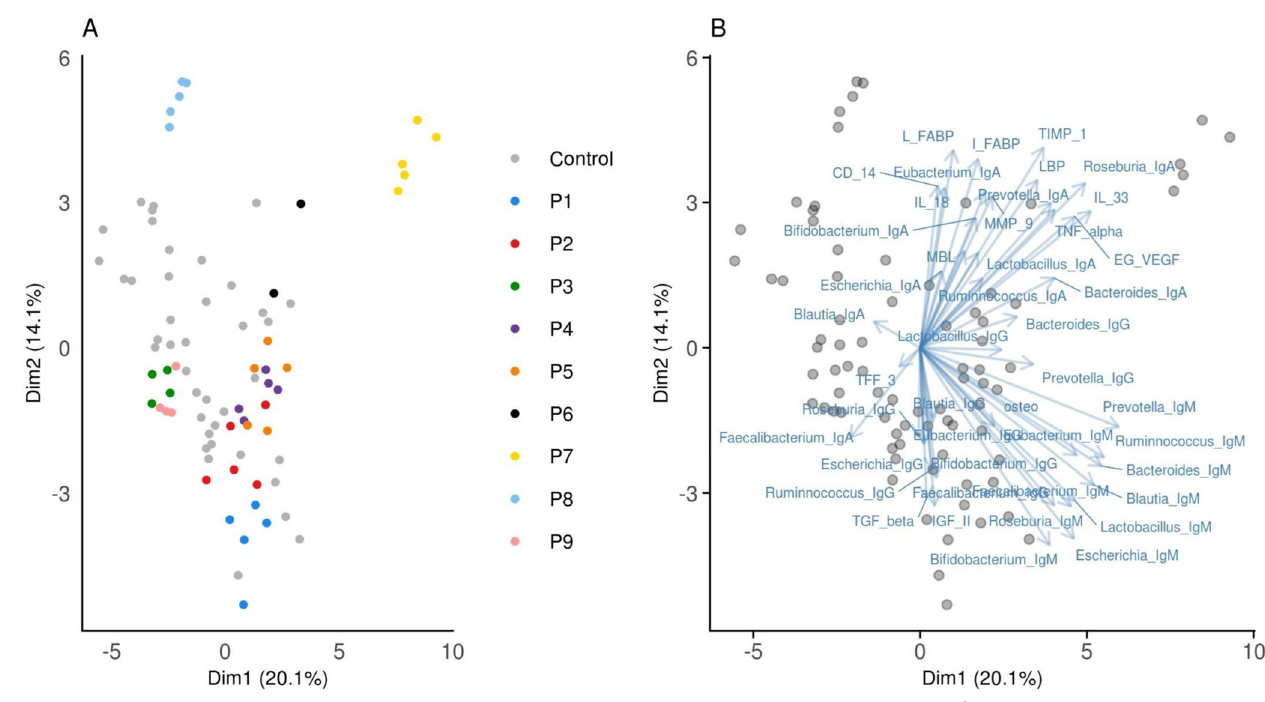
Fig 1. PCA of biomarker concentrations in healthy controls and patients with IBD sampled during ustekinumab treatment. Each dot represents an individual at a specific time point. A) Sample clustering along the first two PCA axes. B) Contribution of each biomarker to the sample ordination (blue